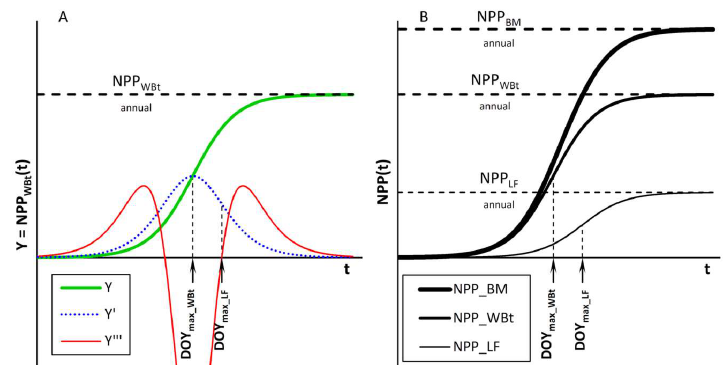
Figure A2. Proposed theoretical framework for calculation of NPP BM . Logistic curve model of NPP WBt ( Y ) has an upper asymptote at NPP WBt annual and the inflexion point and the maximum of Y ’ at DOY max_WBt . DOY max_LF is assumed to occur at the second inflexion point of Y ’ i.e., the point where third derivative Y ’’’ = 0 ( panel A ); annual dynamics of NPP WBt and NPP LF modelled using the same parameter k (see text), and their sum NPP BM ( panel B ).